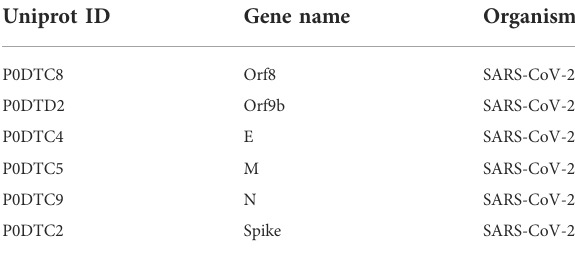
TABLE 1 Proteins of the protein – protein interaction network that resultedaskeyproteinsfromthetopologicalanalysisandgenerated a graph disconnection in the cutoff